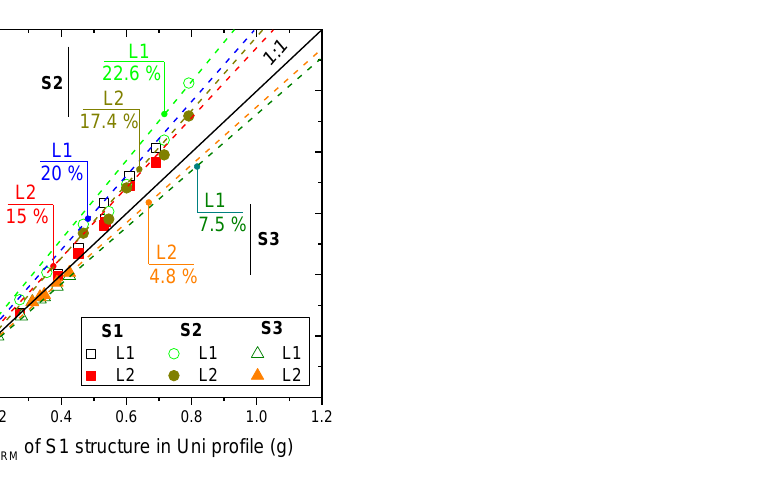
Figure 12. Comparison of peak acceleration of RM (PGA RM ) for the S1, S2, and S3 structures on L1 and L2 profiles with those on Uni profile.